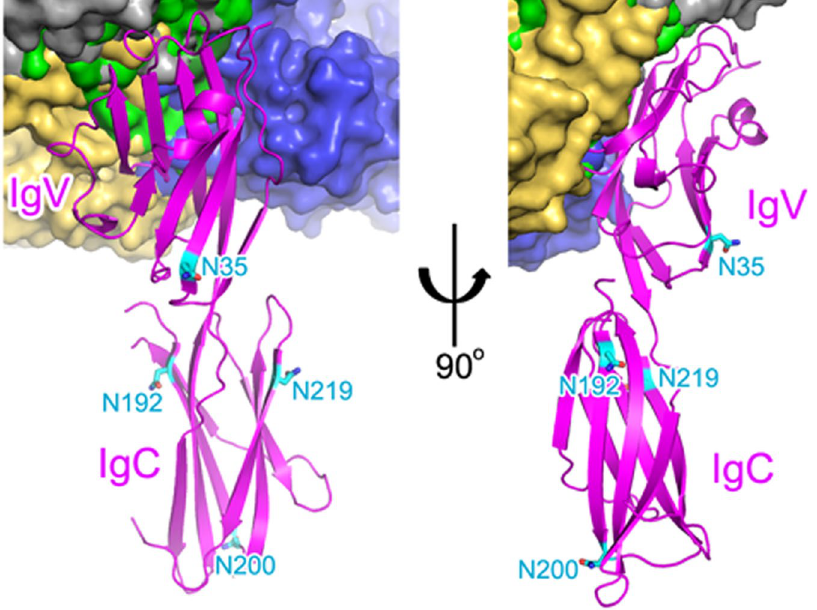
Figure 7. Glycosylation of PD-L1 and antibody binding. The four N-glycosylation sites (N35, N192, N200, and N219) of PD-L1 are shown in sticks and colored cyan. The IgSF V-set and IgSF C-set domains of PD-L1 are labeled. The bound antibodies, including atezolizumab, durvalumab, BMS-963559, and avelumab, are shown as green, blue, gray, and yellow surfaces,